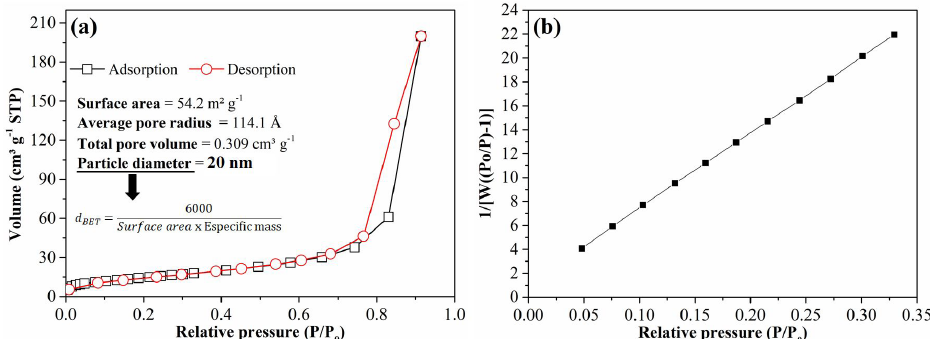
Figure 8. (a) Nitrogen adsorption-desorption isotherms and (b) BET curve of the obtained nanostructured ZnO.